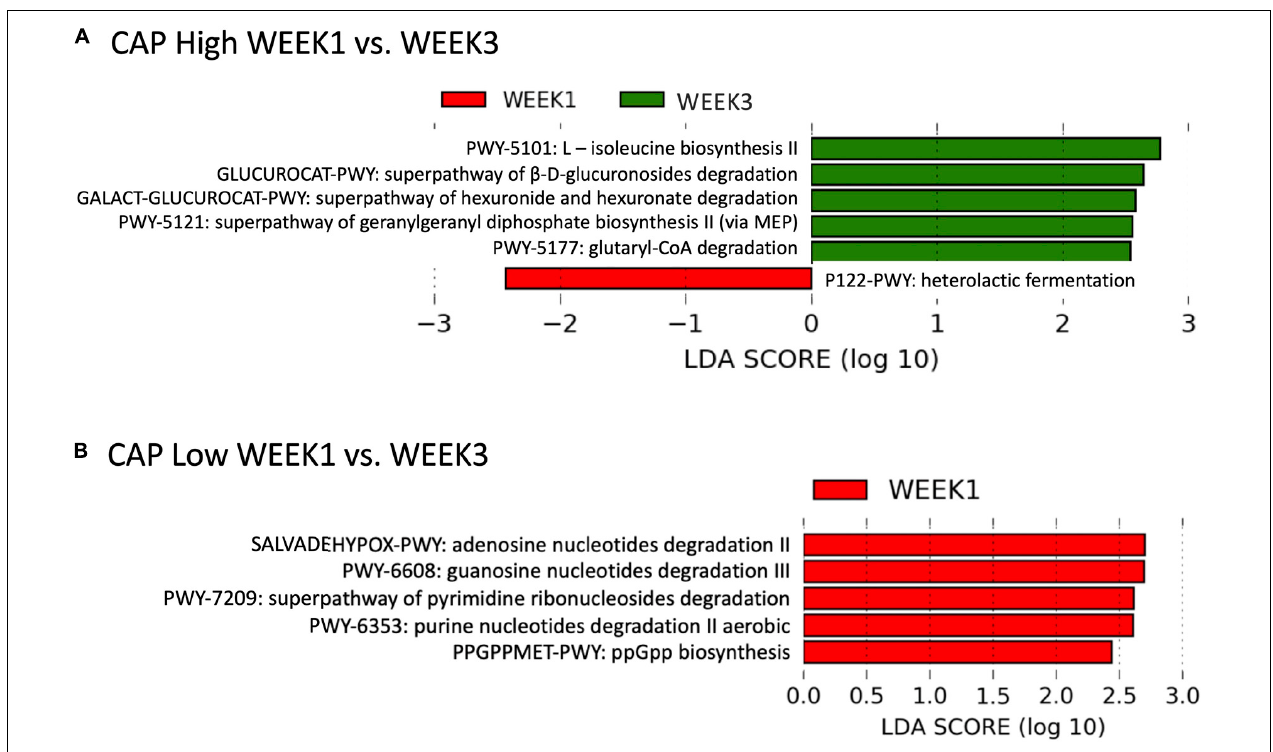
FIGURE 2 | Functional microbial response to alcohol abstinence were different in CAP High and CAP Low patients. (A) In CAP High patients, five microbial pathways were enriched at WEEK 3 (Green) and one microbial pathways were enriched at WEEK 1 (Red). (B) In CAP Low patients, five microbial pathways were enriched at WEEK 1